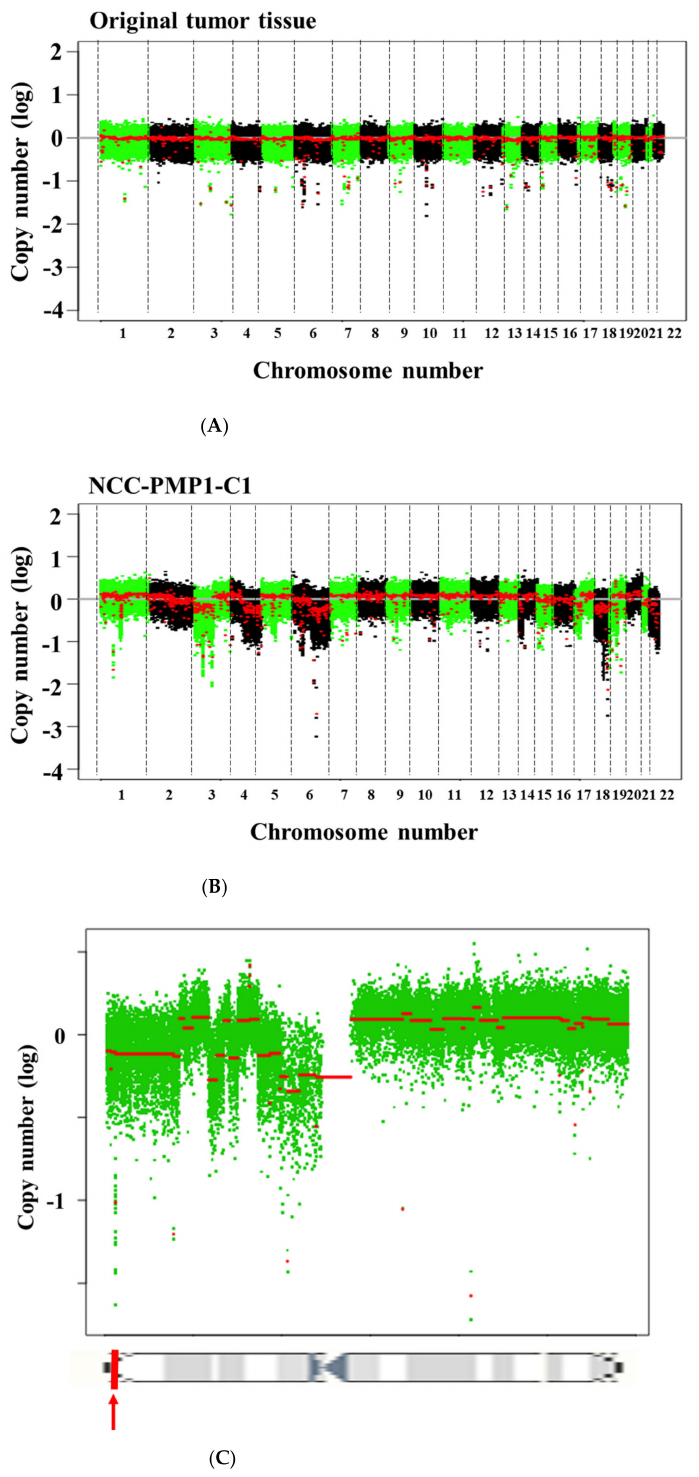
Figure 2. Single nucleotide polymorphism (SNP) array of the original tumor tissue and NCC- PMP1-C1 cells. The profile of copy number variants for the original tumor tissue ( A ) and NCC- PMP1-C1 cells ( B ). The x and y axes indicate the chromosome location and the log ratio of the copy number, respectively. ( C ) The cytogenetic band of chromosome 19 and the copy number variation of chromosome 19. The x- and y-axes indicate the genomic positions and the copy number, respectively. The chromosomal segments are shown as red dots. The location of STK11 is shown with a red bar and